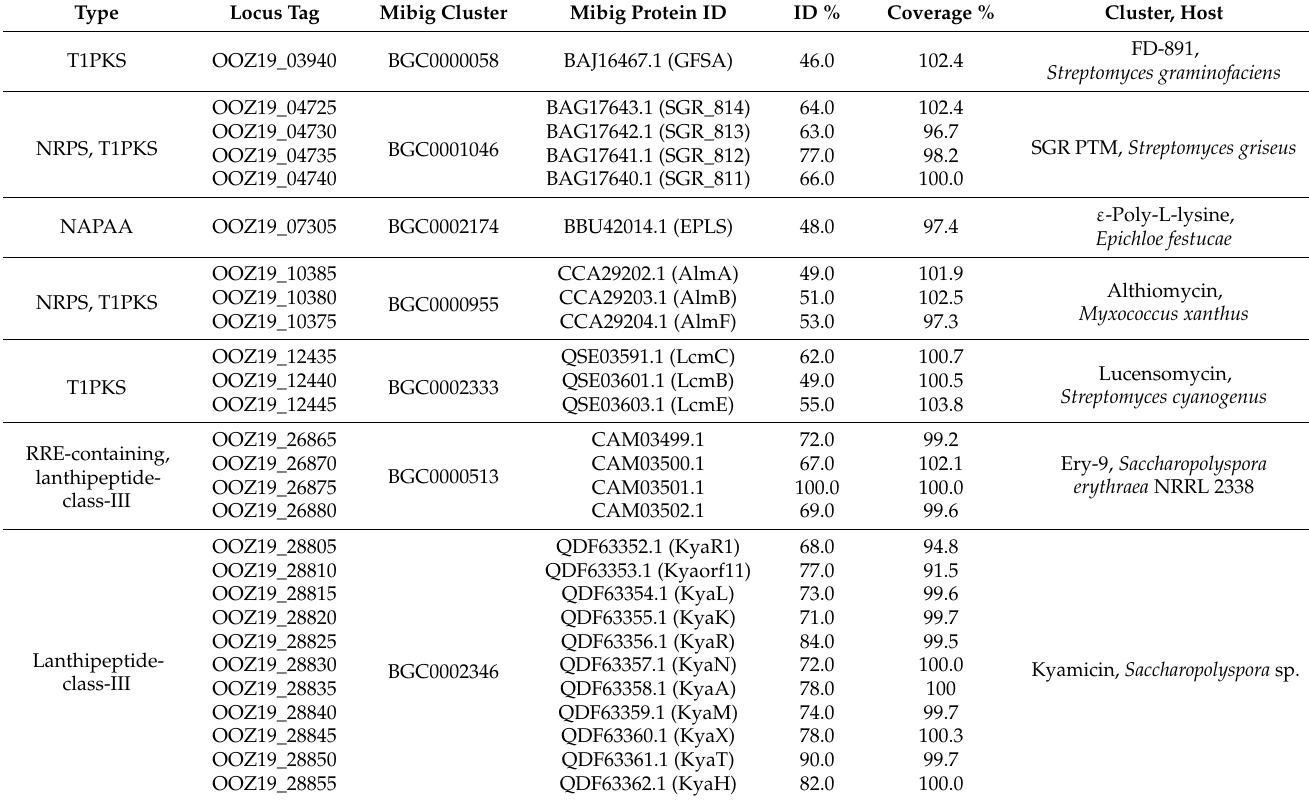
(Table 3). The gfsA gene is part of a biosynthetic gene cluster of Streptomyces graminofaciens encoding FD-891, a 16-membered macrolide antibiotic with antitumoral effects [65]. While some similarity was found between gfsA and NFXS83 OOZ19_03940 encoded proteins the remaining gfsBCDEF genes were not detected in the NFXS83 genome. These results suggest that NFXS83 OOZ19_03940 may encode a different type of antibiotic compound. Table 3. Detailed analysis of Saccharopolyspora sp. NFXS83 biosynthetic gene clusters 2, 3, 4, 7, 8, 10,